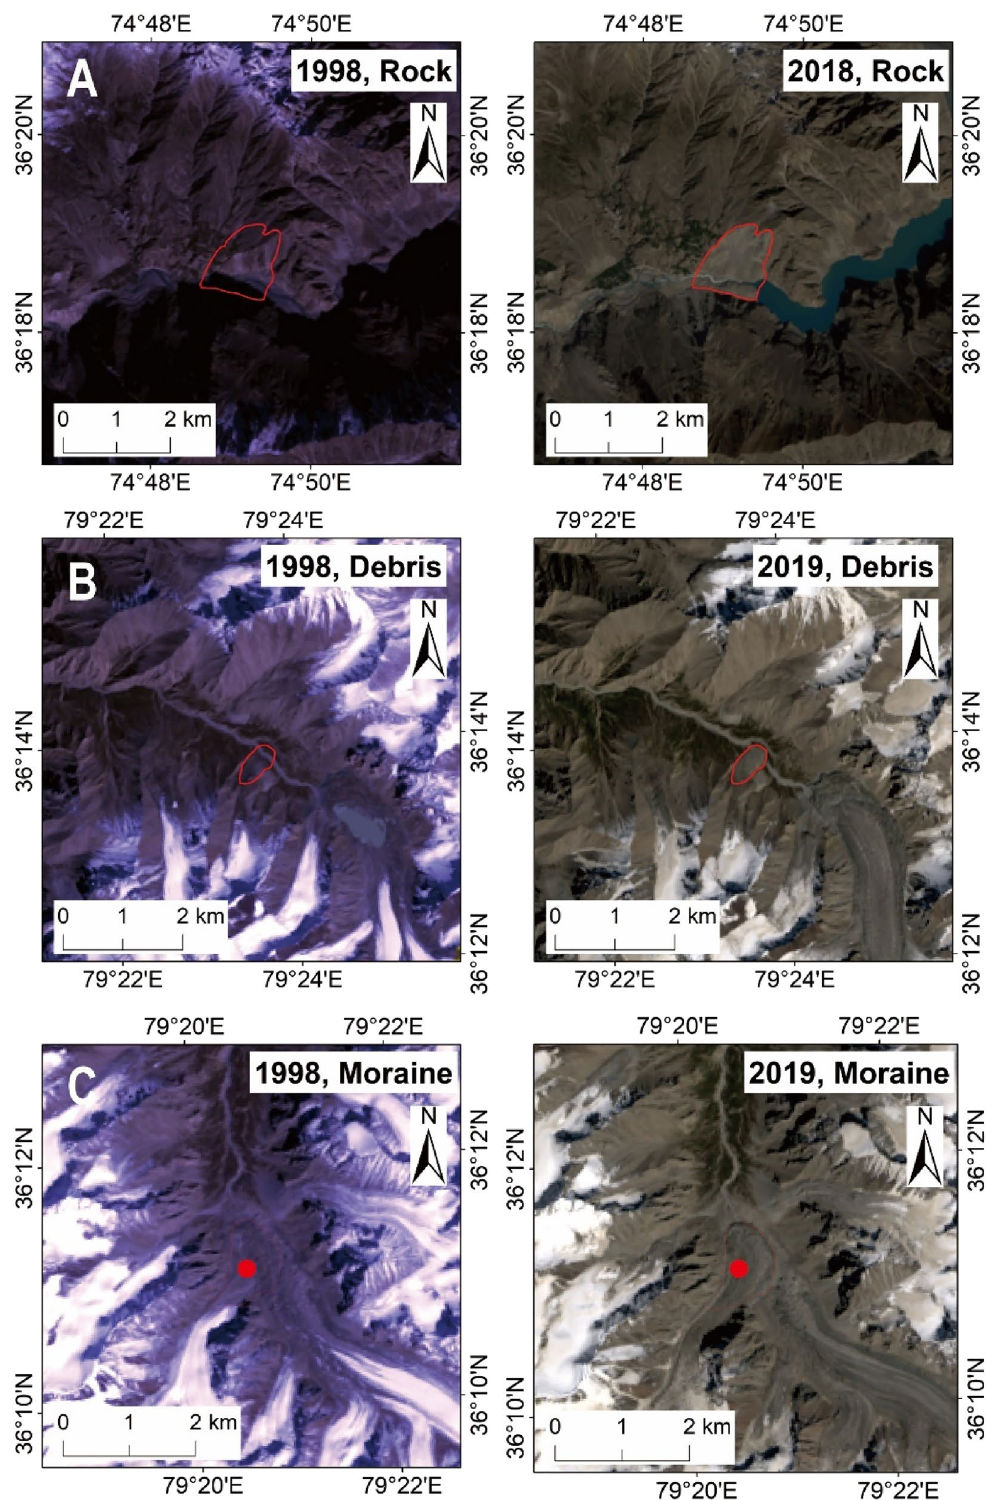
Figure 1. Comparison of three types of landslide source area. ( A – C ) are shows the landslides of rock, debris, and Moraine material types (Figures created using Arcgis10.2 https ://www.esri.com/en-us/arcgi s/produ cts/arcgi s-deskt